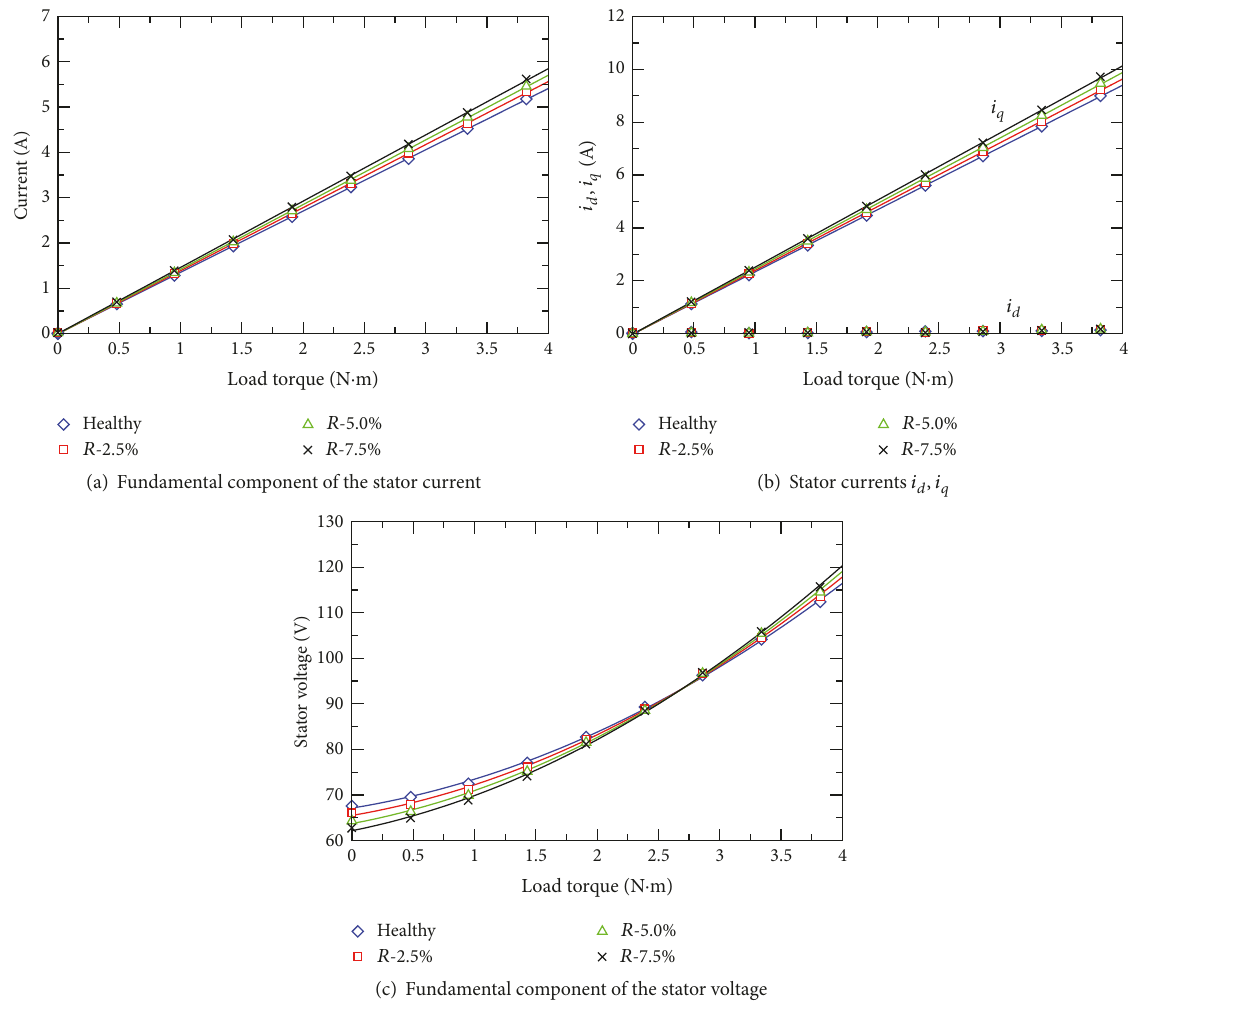
Figure 20: Simulated results using vector